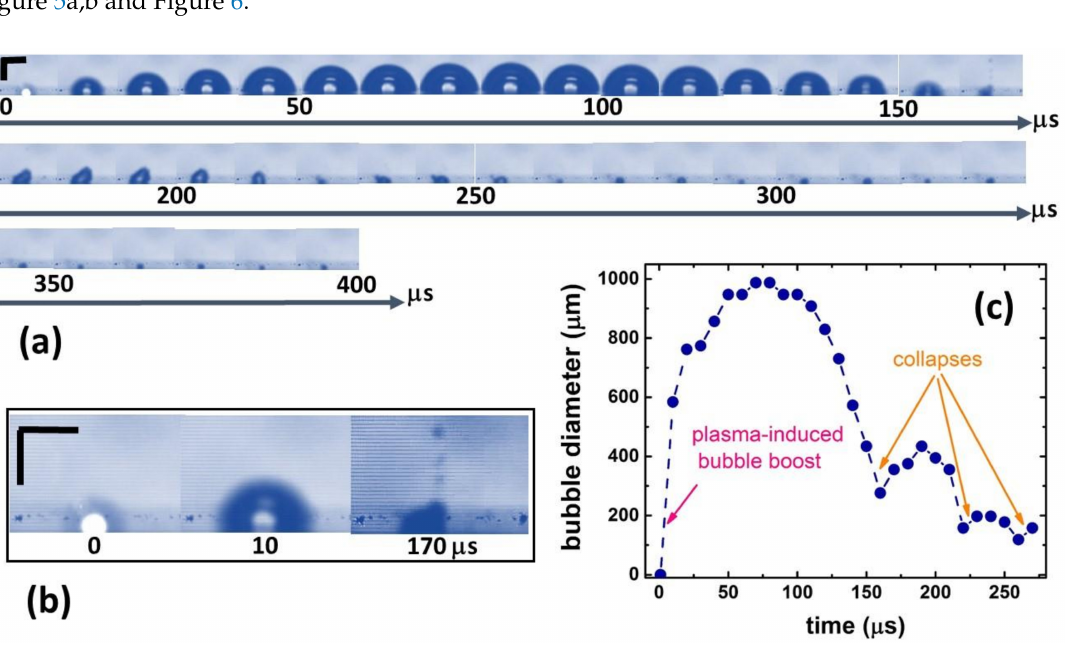
Figure 5. Plasma-driven vapor bubble dynamics on Si wafer surface ablated by single 1064-nm, 200-ns pulses at laser intensity of 4 GW/cm 2 : ( a ) Top three lines: Time series of bubble images (vertical and horizontal scale bars—500 µ m), ( b ) Time series of the selected images (vertical and horizontal scale bars—500 µ m), ( c ): Dependence of bubble diameter versus